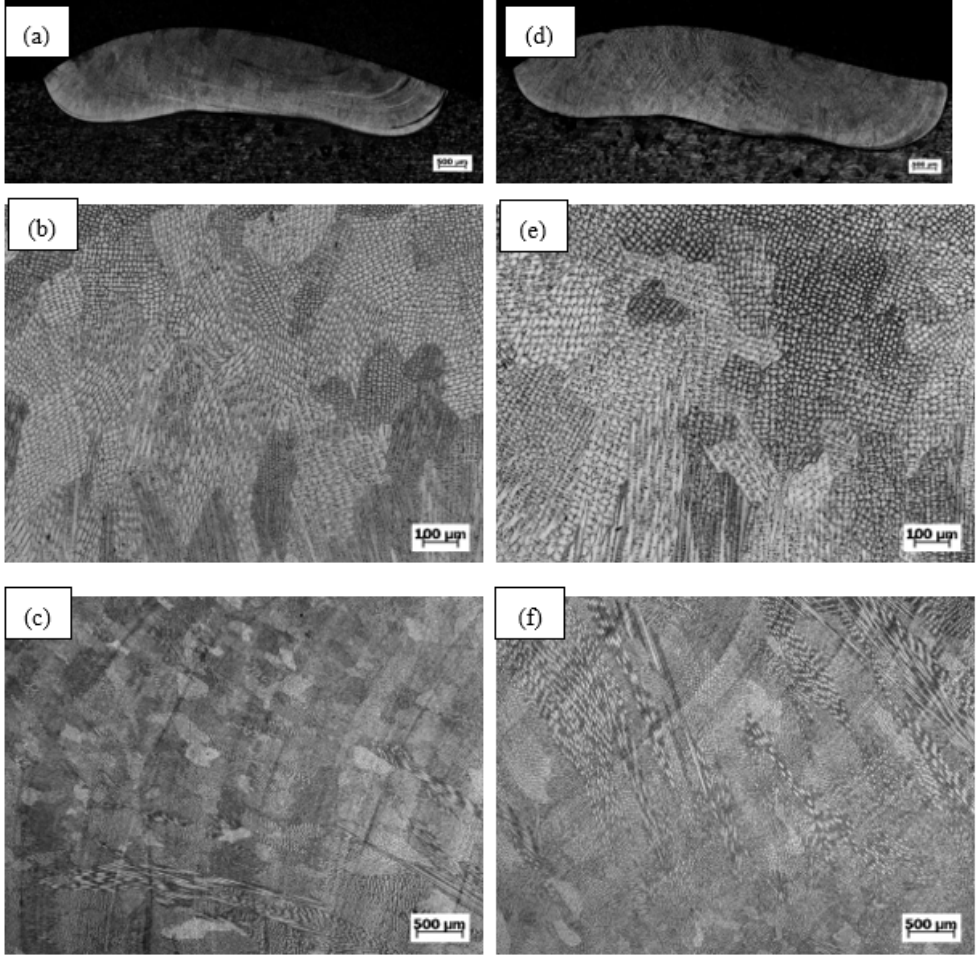
Figure 10. Microstructure comparison of 150 A/200 A current cladding metal: ( a – c ) 150 A; ( d ) 200 A, macro-section; ( e ) 200 A, micro-section; ( f ) 200 A, macro-surface.